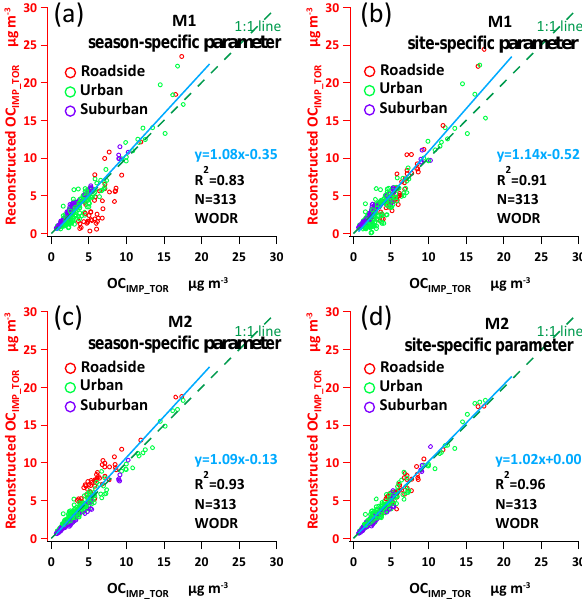
Figure 7. Comparison of reconstructed EC IMP_TOR and measure- ment EC IMP_TOR in the year 2013. (a) Regression by season- specific parameters using M1. (b) Regression by site-specific pa- rameters using M1. (c) Regression by season-specific parameters using M2. (d) Regression by site-specific parameters using M2.